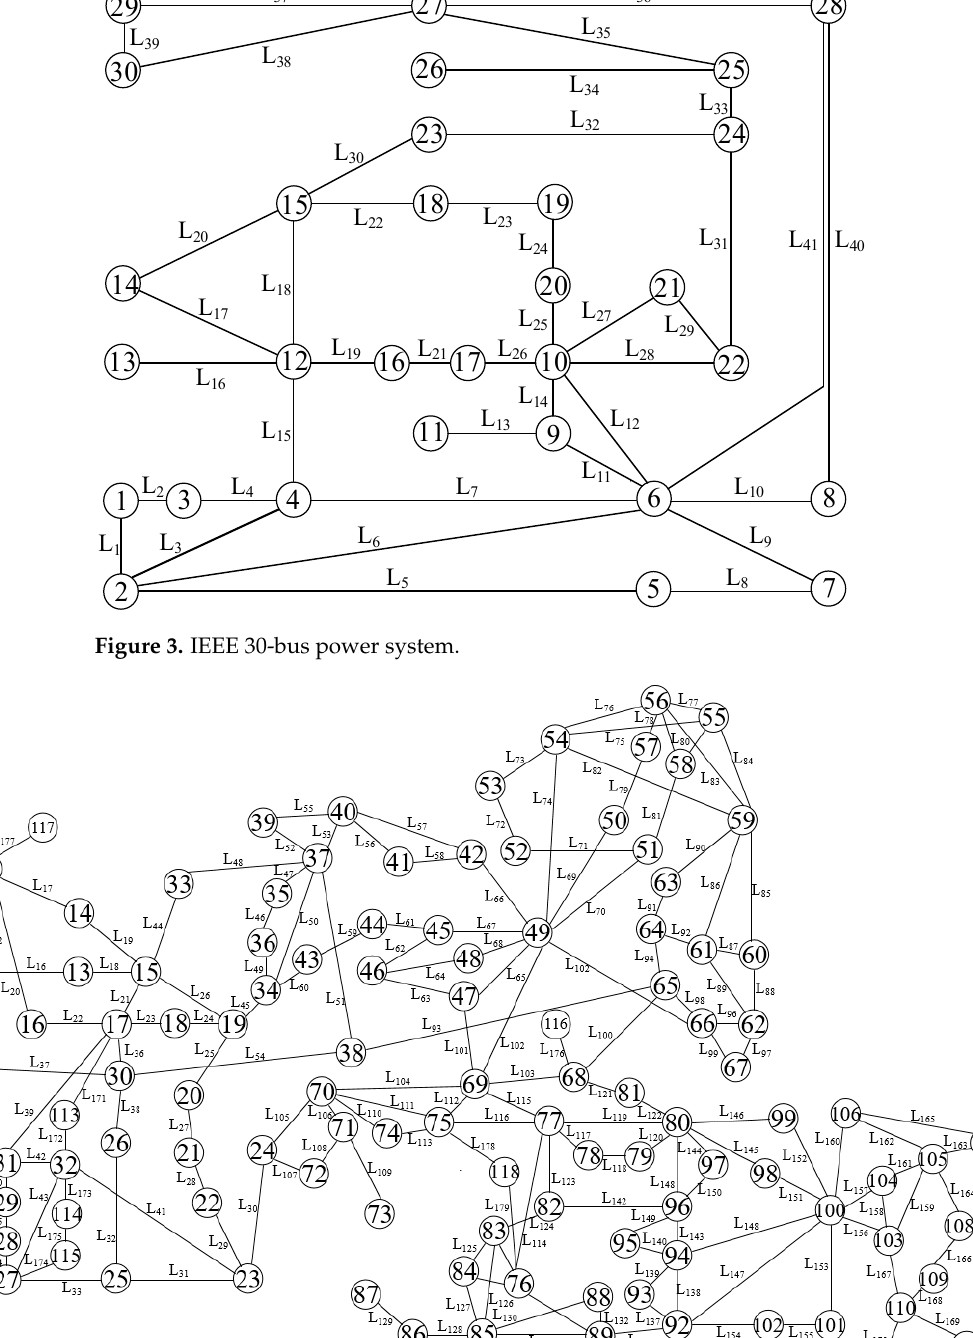
Figure 4. IEEE 118-bus power system.